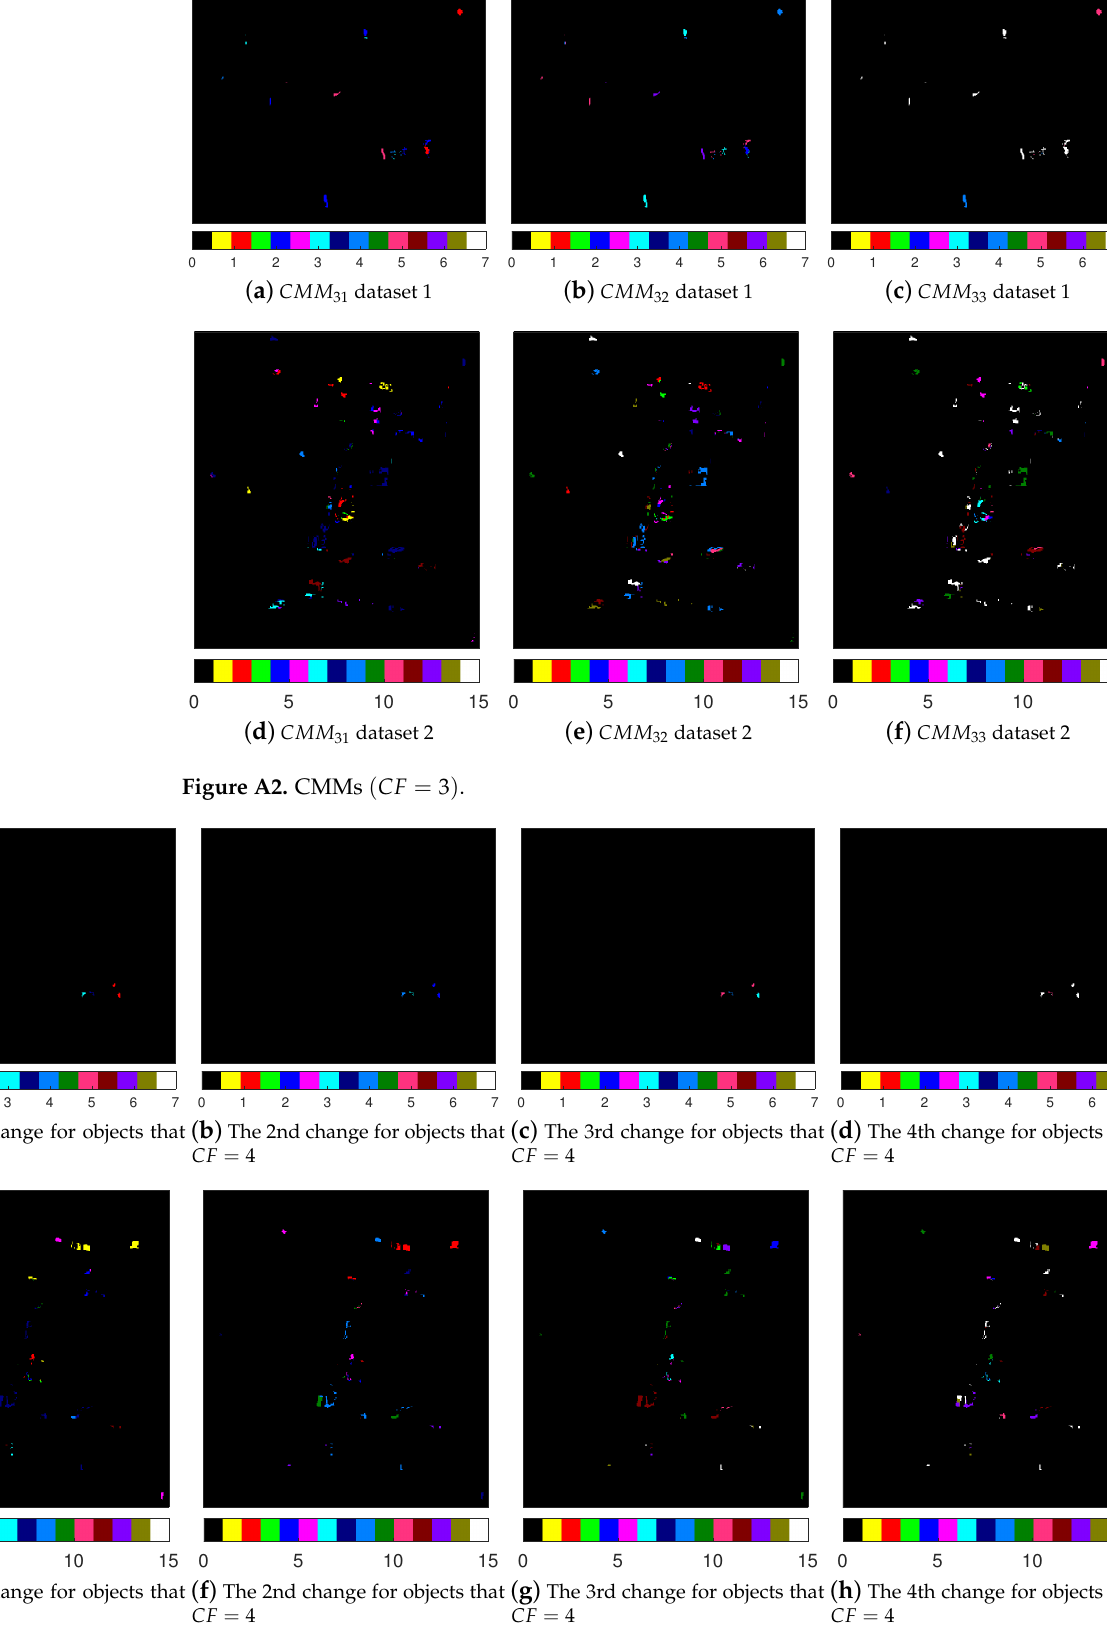
Figure A3. CMMs ( CF = 4 )